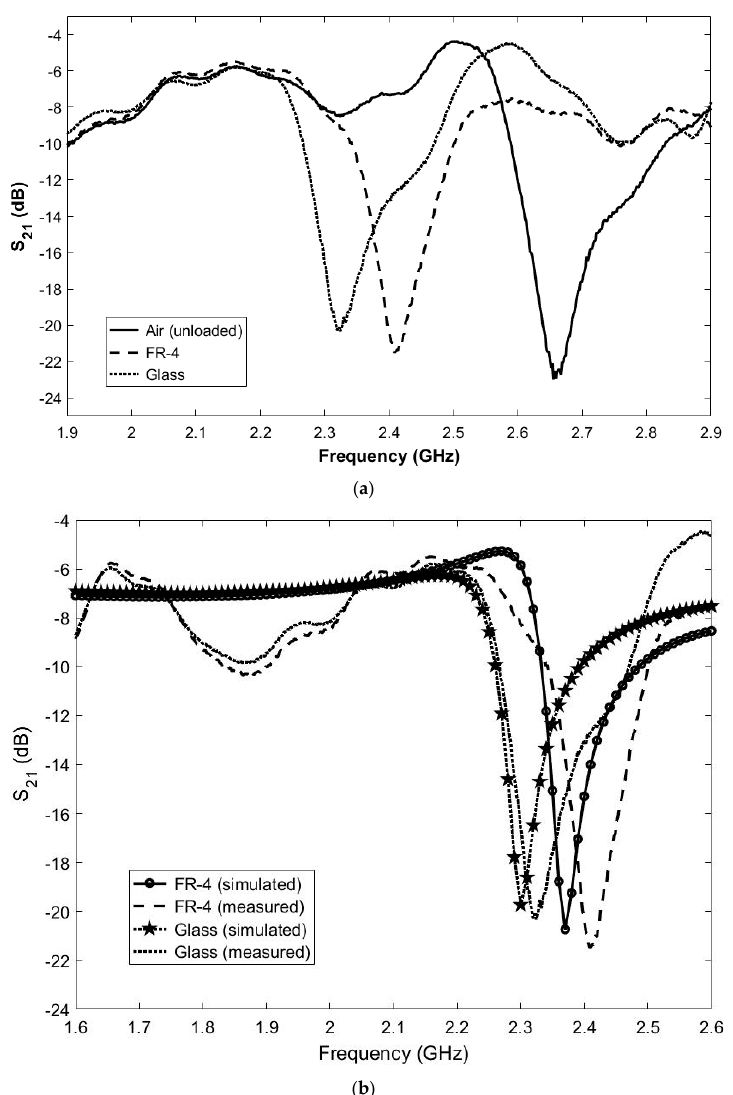
Figure 14. ( a ). Measured results of the transmission coefficient (S 21 ) for unloaded and loaded sensor geometries. ( b ). Simulated and measured results of the transmission coefficient (S 21 ) for the sensor geometries loaded with FR-4 and glass MUT samples.